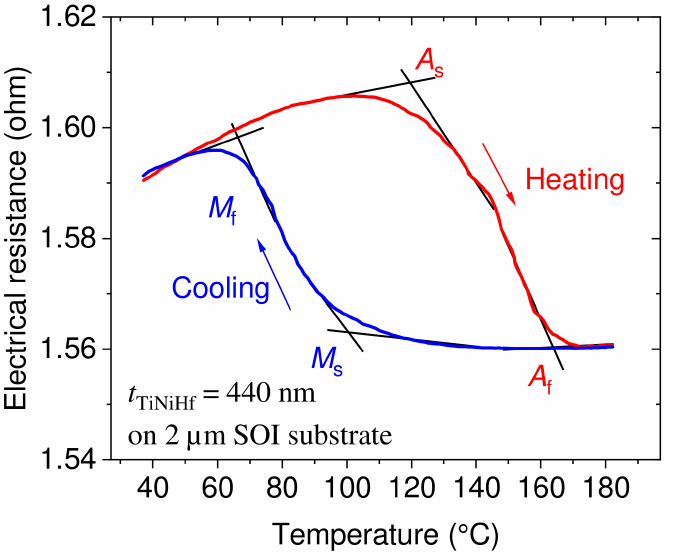
Figure 1. Temperature-dependent electrical resistance characteristic of a 440 nm thick TiNiHf film on a 2 µ m thick Si device layer of a SOI substrate. The start and finish austenitic and martensitic trans- formation temperatures (As = 119.3 ◦ C, Af = 163.7 ◦ C, Ms = 100.2 ◦ C, Mf = 65.6 ◦ C) are determined using the tangential